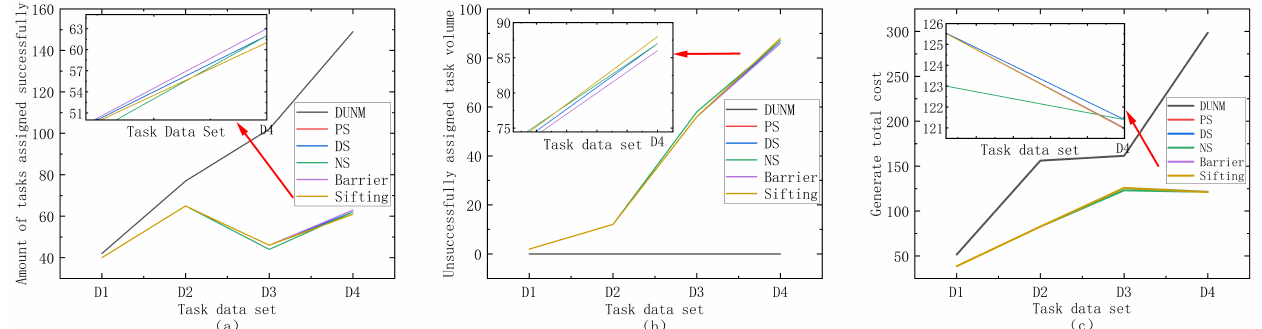
Figure 10. Performance comparison of various algorithms on different task datasets. ( a ) Successful task assignments. ( b ) Unsuccessful task assignments. ( c ) Total revenue